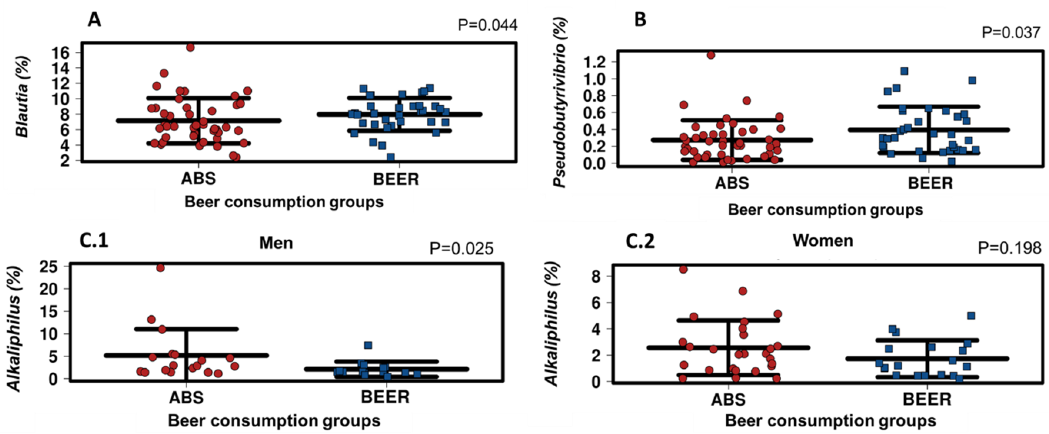
Figure 2. Differences between beer consumption groups in the abundance of the genus Blautia ( A ), Pseudobutyrivibrio ( B ), and Alkaliphilus ( C ). The Alkaliphilus genus is stratified in men ( C.1 ) and women ( C.2 ). MW-U test. Significance at p < 0.05.